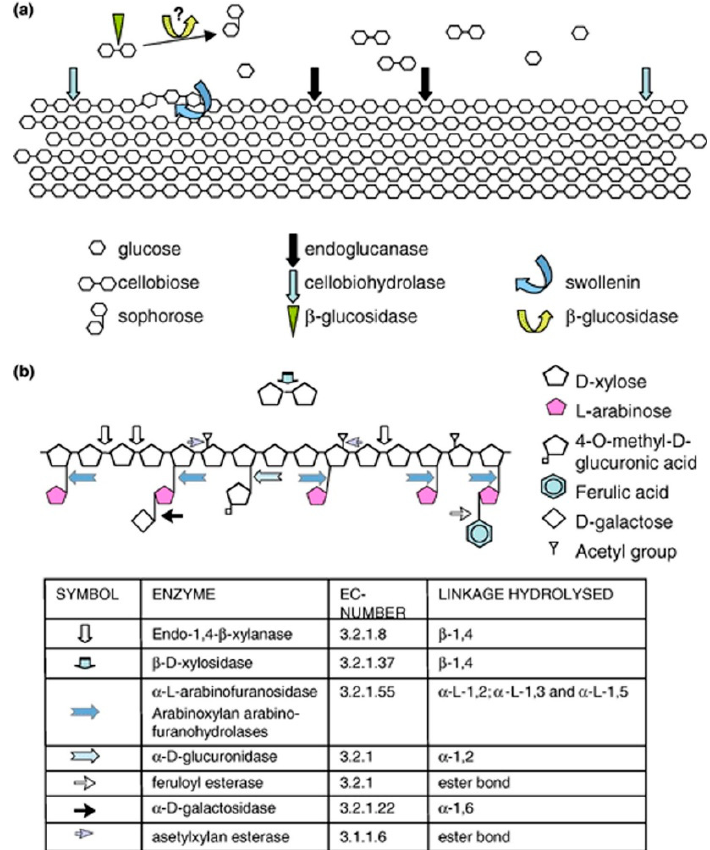
Figure 2. Schematic representation of cellulose and hemicellulose degradation by Aro et al., Tran- scriptional regulation of plant cell wall degradation byfilamentous fungi, published by Oxford University Press, 2020 [32]. (a): The degradation of cellulose; (b): the degradation of